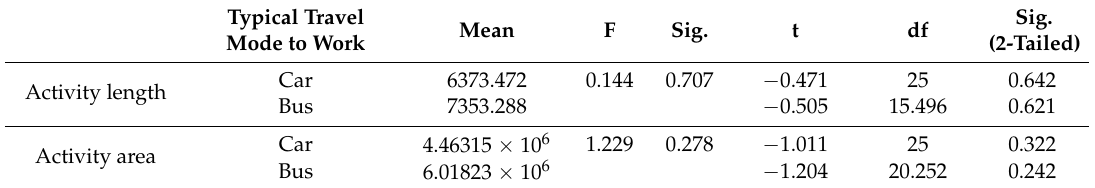
Table 1. Travel mode (bus and car) wise difference in activity